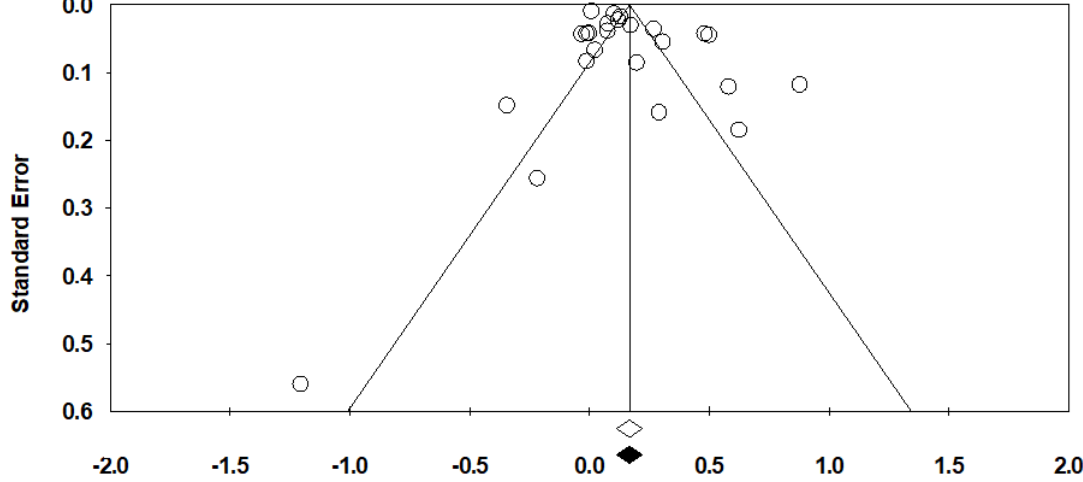
Figure 3. Funnel plot for publication bias for the overall risk of cancer with antibiotic use.